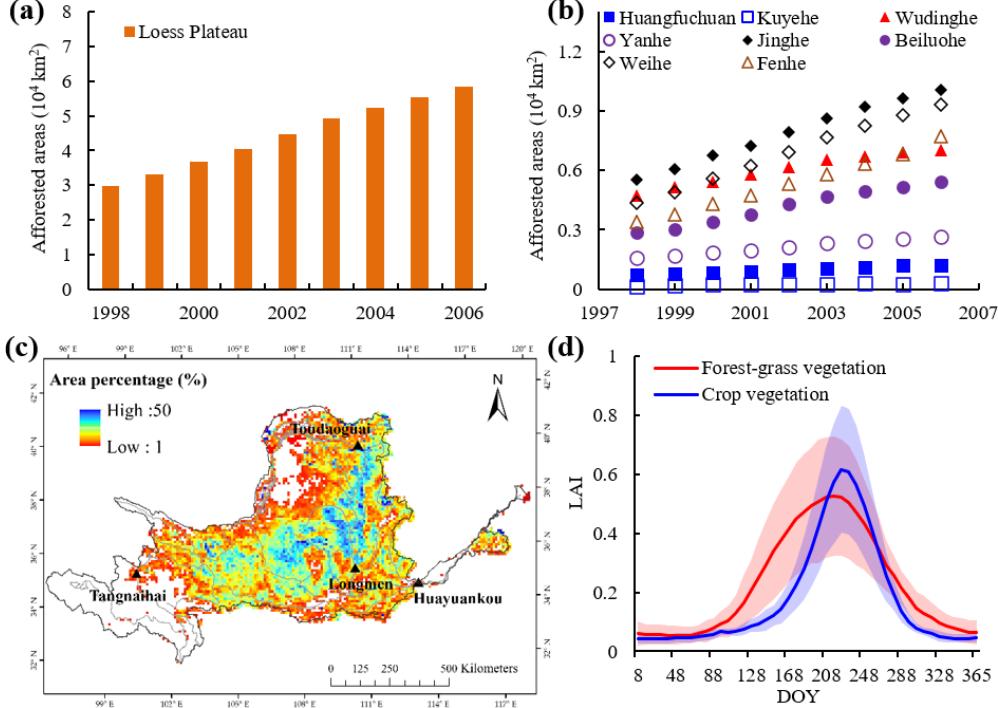
Figure 11. (a) Total afforested areas implemented in the Loess Plateau from 1998 to 2006; (b) Afforested areas in different watersheds between 1998 and 2006; (c) spatial distribution of area percentage of the conversion of cropland into forest grass during 1985–2020 in each 0.1 ◦ grid cell; (d) the intra-annual variation of LAI at the 8d scale for typical forest-grass vegetation and crop vegetation; the solid line and shaded area indicate the mean and ±